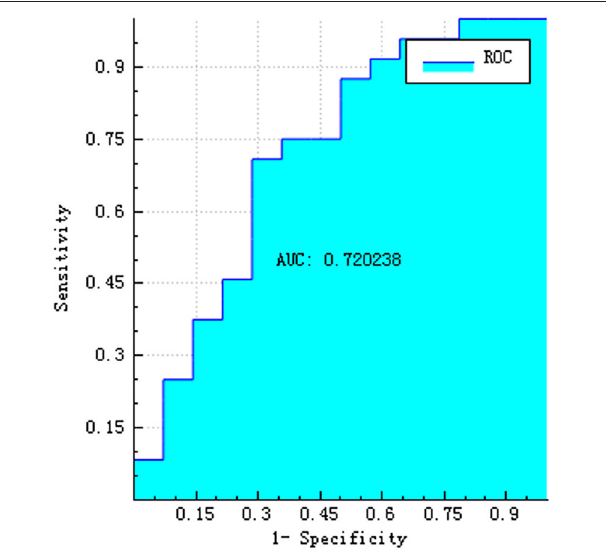
FIGURE 5 | ROC curve of testing